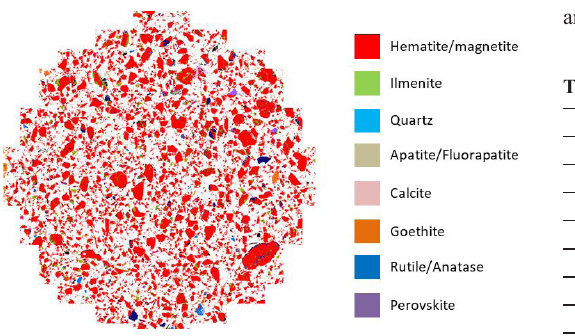
Figure 2. Geological profile of the phosphate-ore mine in Alto Paranaíba 29 .